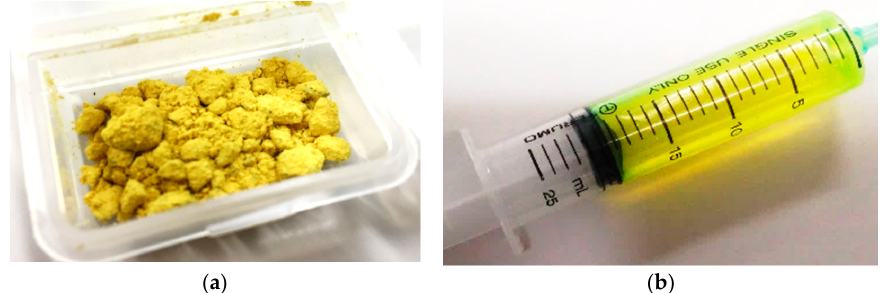
Figure 3. ( a ) Pyranine substance, ( b ) Fluorescence solution of pyranine.